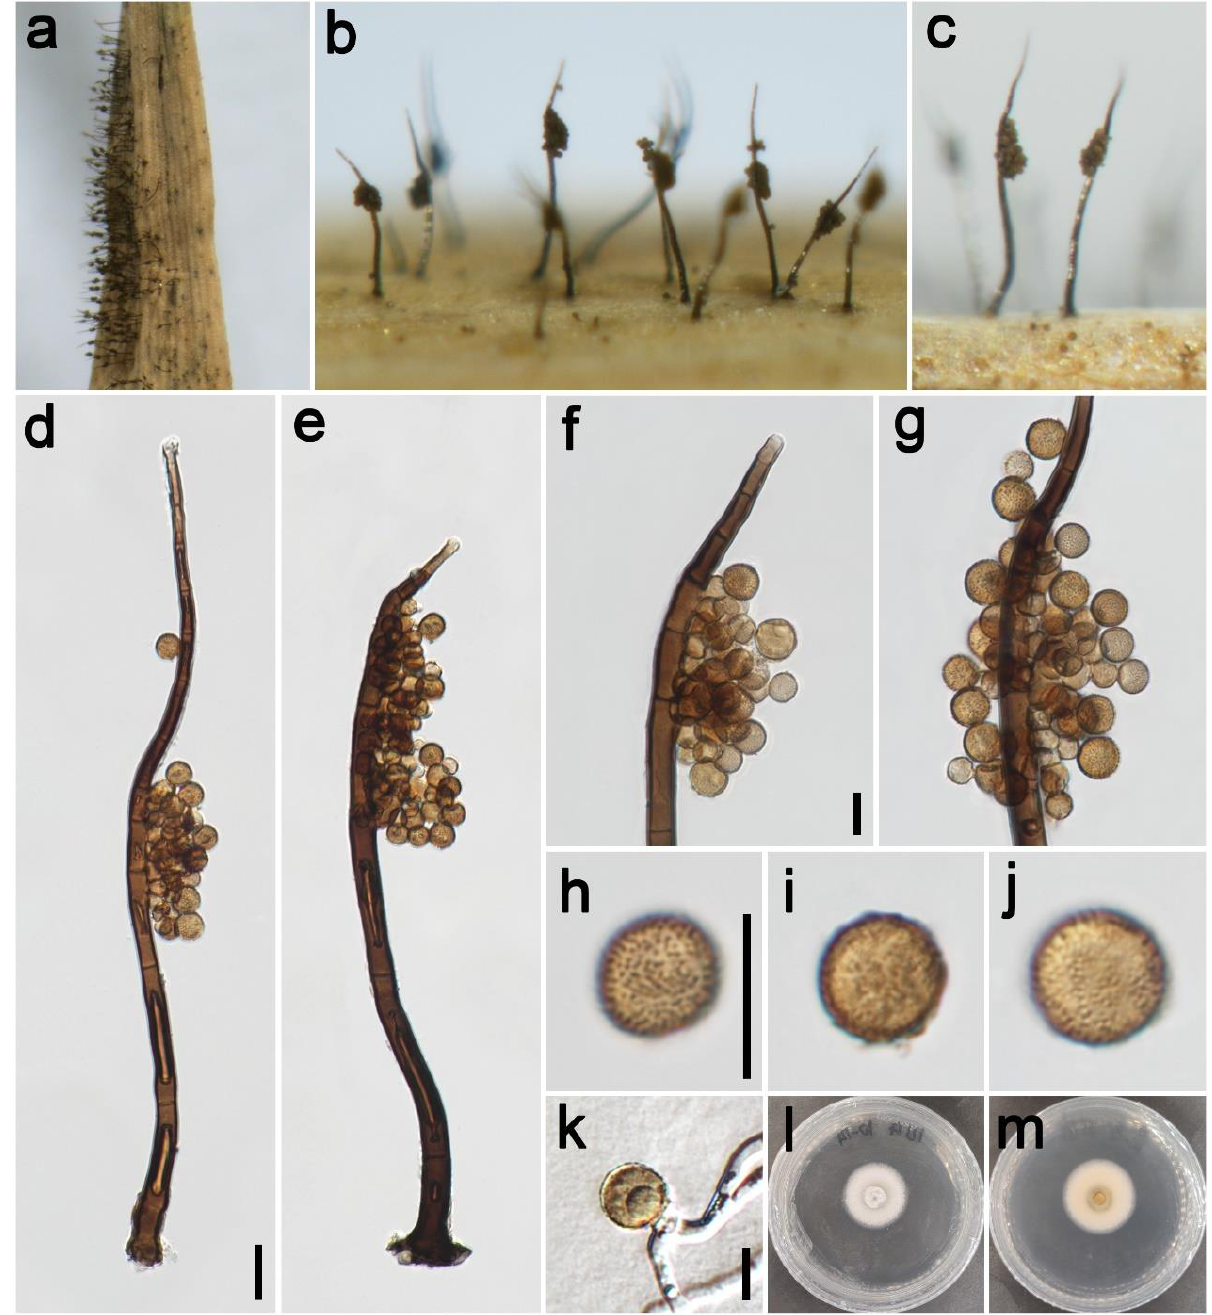
Figure 6. Periconia cynodontis (HKAS 126515, holotype). ( a – c ) Colonies on the natural substrate; ( d , e ) conidiophores; ( f , g ) conidiophores bearing conidia laterally; ( h – j ) conidia; ( k ) germinating conidium; ( l , m ) colony on PDA from above and below. Scale bars: ( d ) = 20 µm, ( f , h , k ) = 10 µm. Scale bar of ( d ) applies to ( e ). Scale bar of ( f ) applies to ( g ). Scale bar of ( h ) applies to ( i , j ).